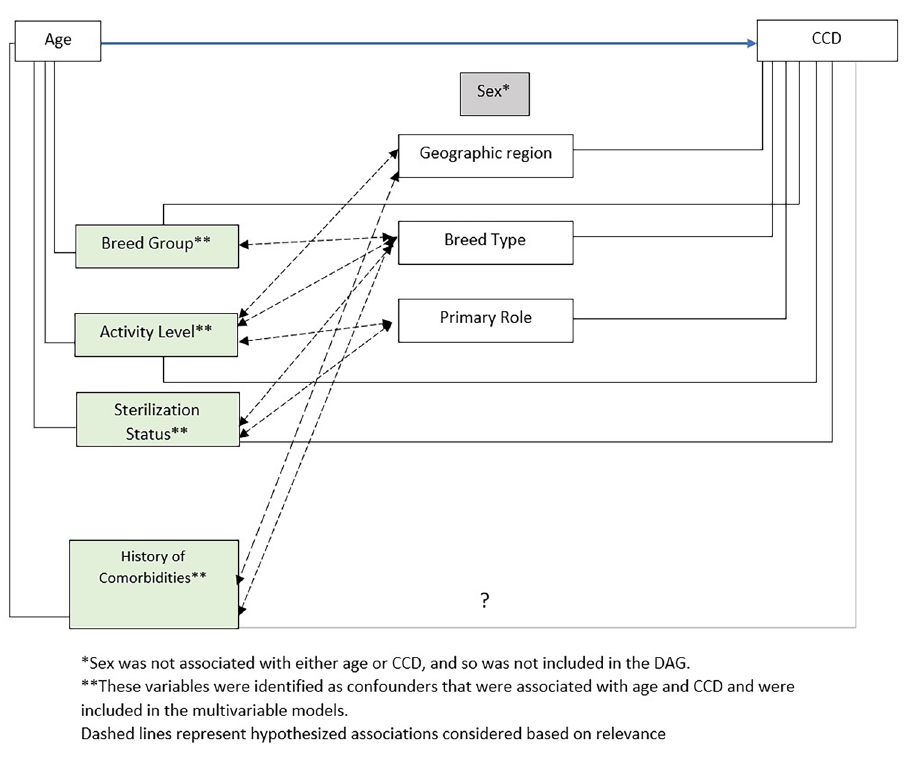
Figure 2. Directed Acyclic Graph (DAG) representing associations between Canine Cognitive Dysfunction, age, and other characteristics of interest, Dog Aging Project,